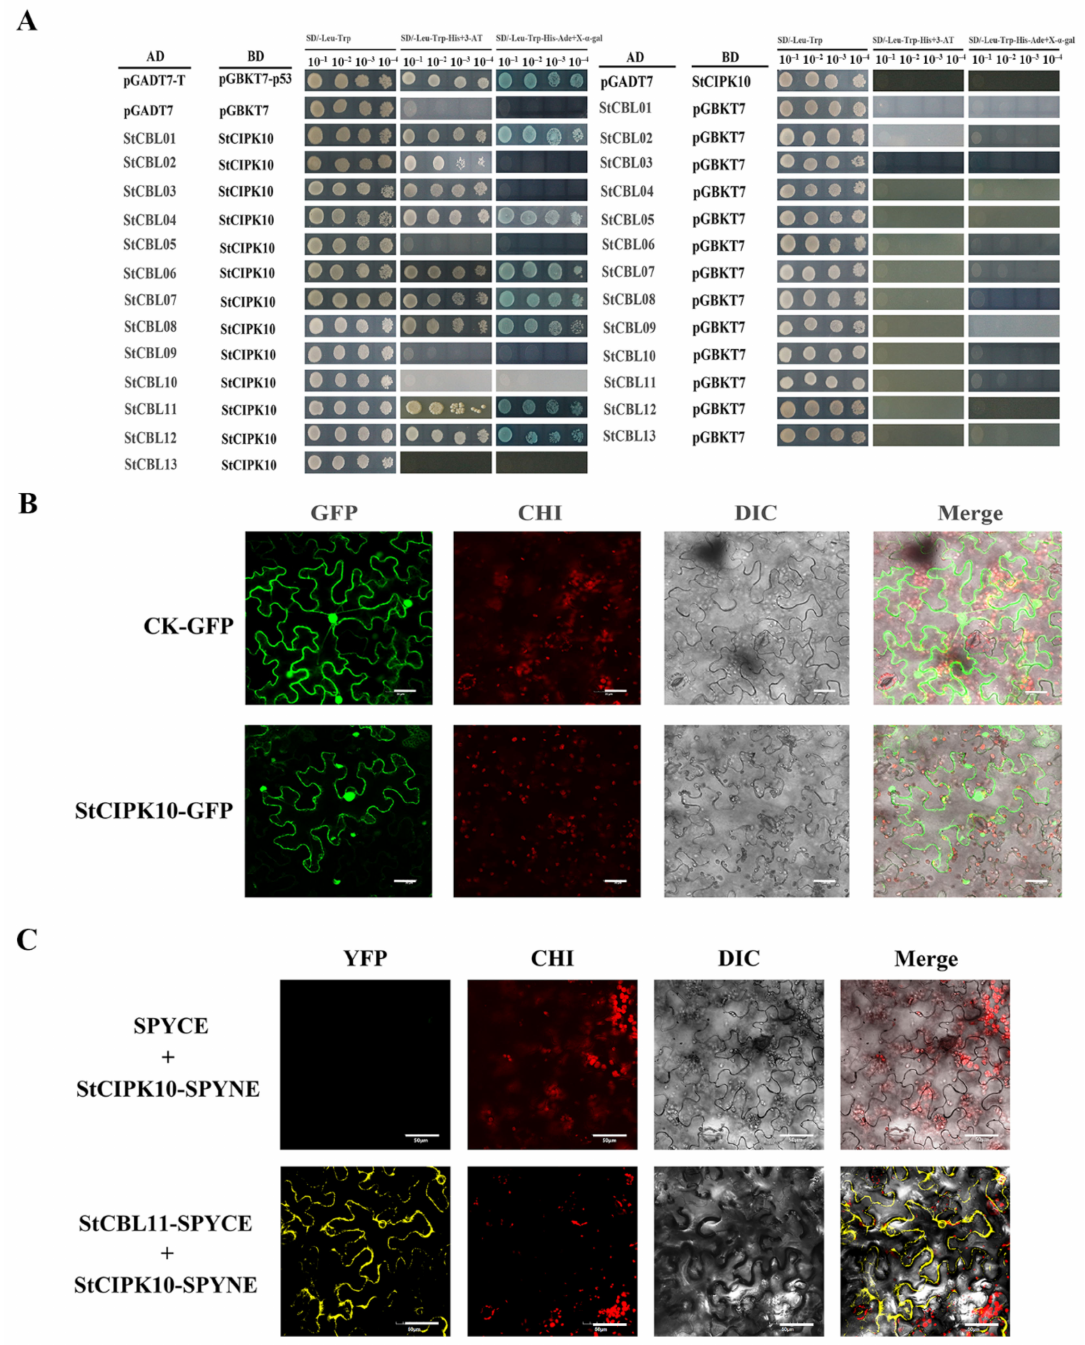
Figure 8. Interaction between StCIPK10 and StCBLs demonstrated by yeast two-hybrid assay and BiFC. ( A ) Y2H assay analyzing the interaction between StCIPK10 (bait) and StCBLs (prey). The pGADT7-T and pGBKT7-p53 pair was used as a positive control. Transformants were spotted separately on SD/-Leu/-Trp medium, SD/-Leu/-Trp/-His medium with 10 mM 3-AT and SD/-Leu/-Trp/-His/-Ade medium with X- α -gal. Each colony was resuspended in 10 µ L sterile water and then diluted from 10 − 1 to 10 − 4 . At least three colonies per vector combination were tested. ( B ) Subcellular localization analysis of StCIPK10-GFP in Nicotiana benthamiana leaves. An empty vector (GFP) served as a control. Bars = 30 µ m. ( C ) BiFC assay of the interaction between StCIPK10 and StCBL11. StCIPK10 was introduced into the pSPYNE vector and fused with N -terminal YFP; StCBL11 was introduced into the pSPYCE vector and fused with C -terminal YFP. YFPc + StCIPK11–YFPn was used as a negative control. CHI: chloroplast; DIC: bright light. Bars = 50 µ